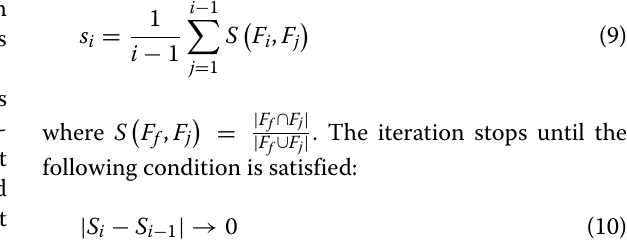
Algorithm 1. In the first part, feature types are selected based on Eq. (8) until other feature types can not